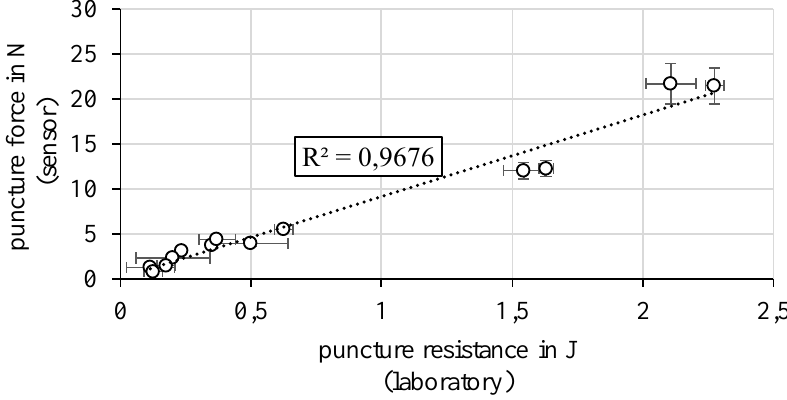
Figure 5. Correlation between the puncture resistance measured in the laboratory and the puncture force measured by the sensor.